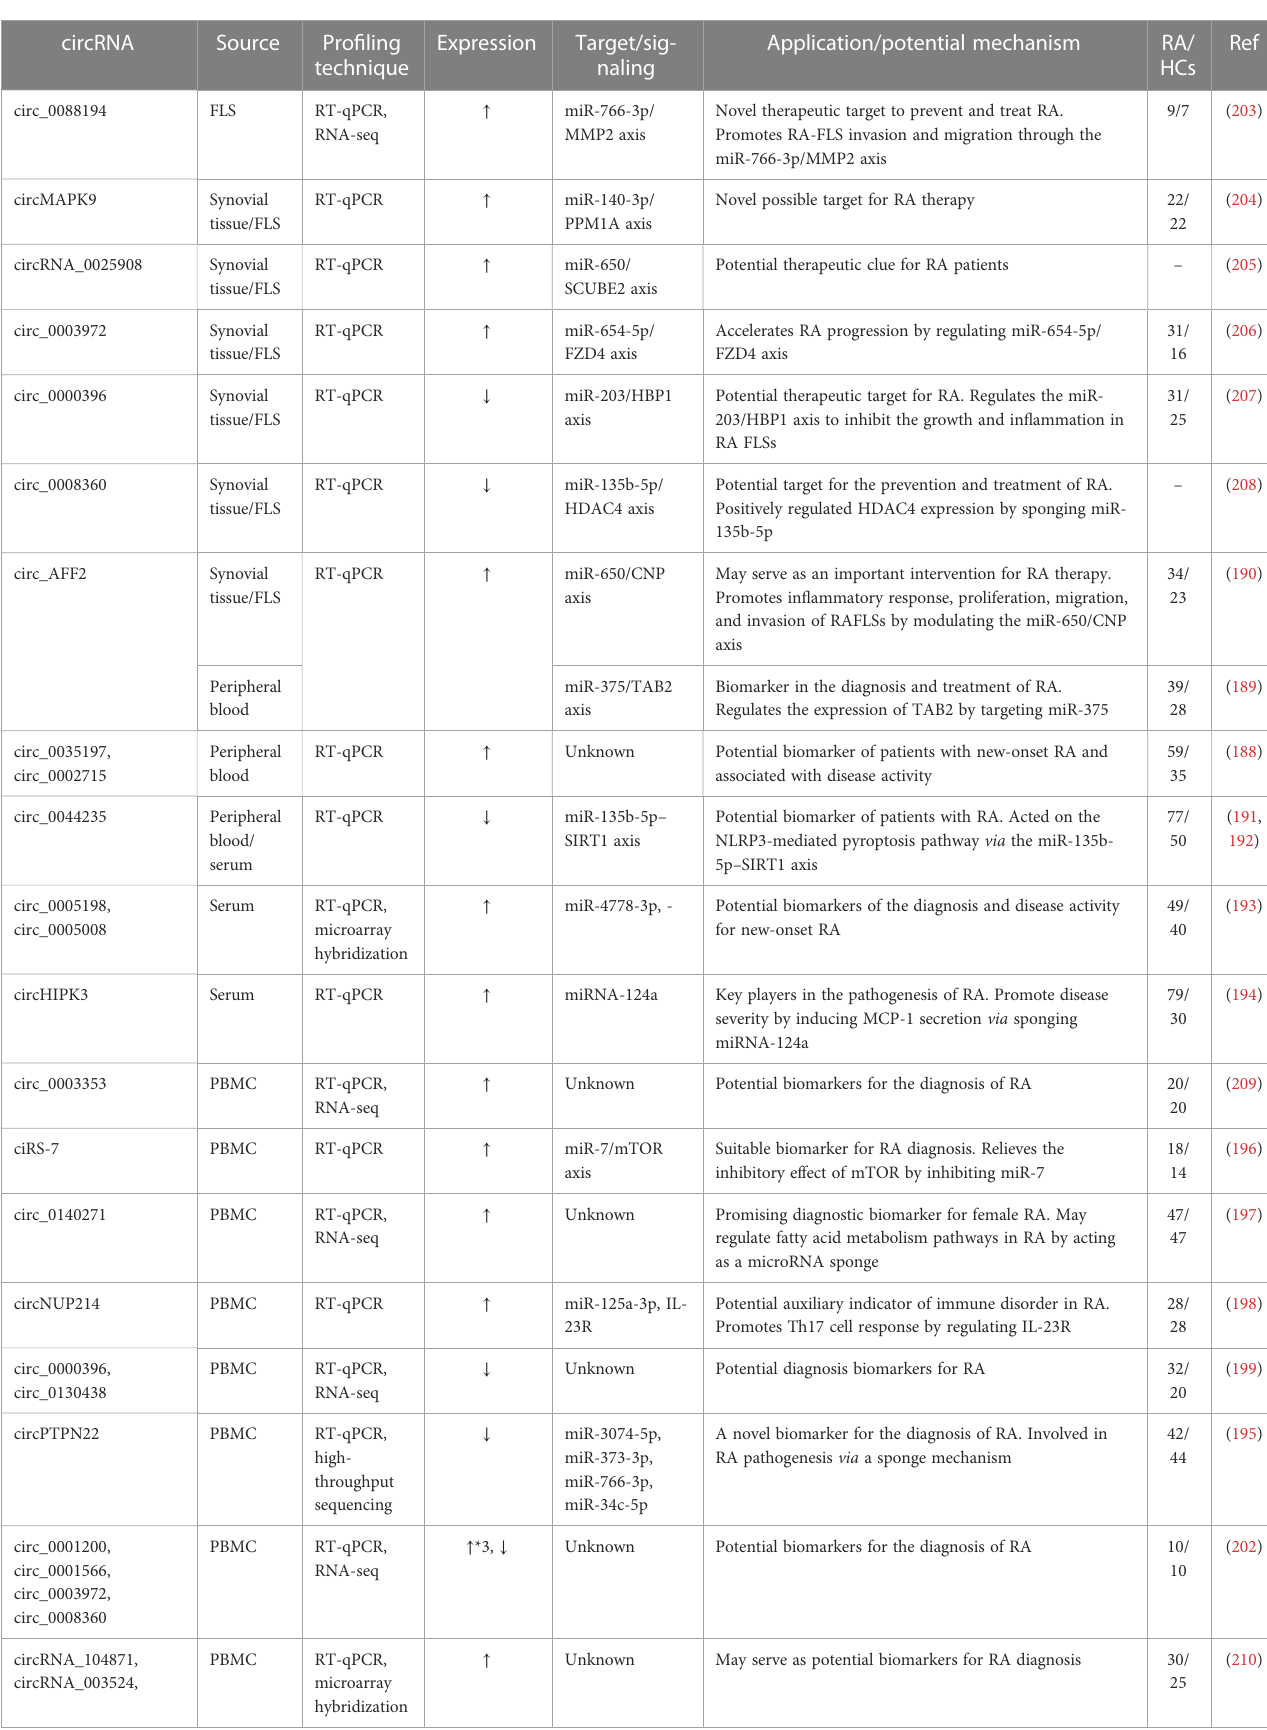
TABLE 4 Potential circRNA biomarkers for